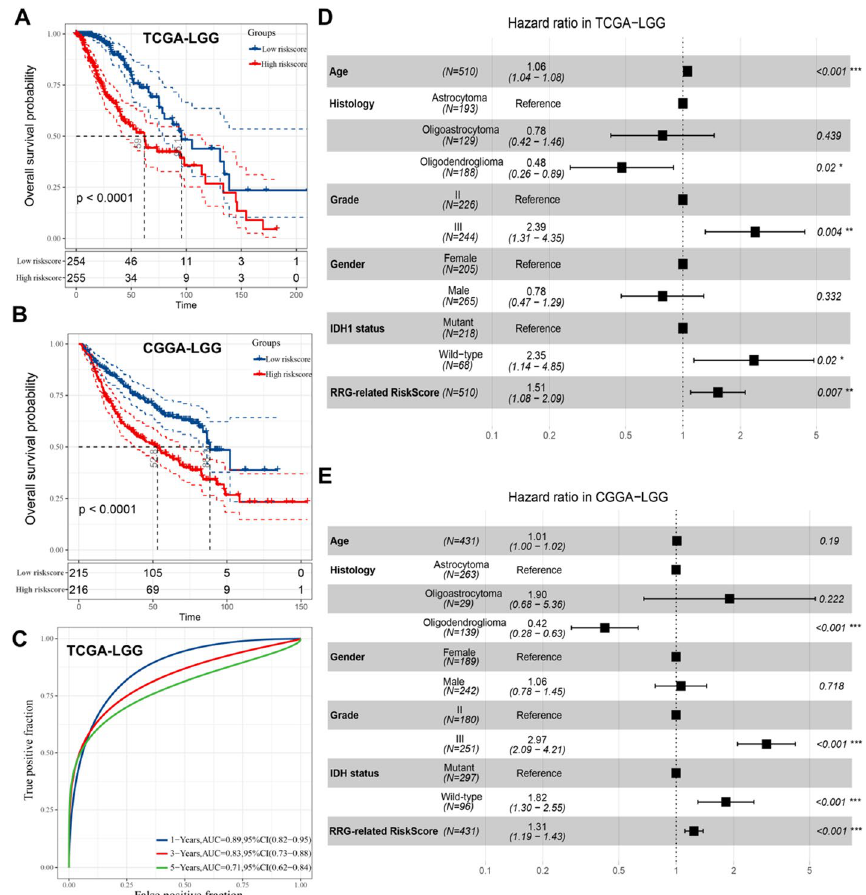
Fig. 7 Construction of RRG-related RiskScore. a , b Kaplan–Meier curves for OS showing the difference in survival between high-RiskScore group and low-RiskScore group in the TCGA ( a ) and CGGA ( b ) cohorts (log-rank test, p < 0.0001). High-RiskScore group is indicated in red line and low-RiskScore group in blue. c The predictive value of RiskScore in patients among the TCGA cohort (AUC:0.89, 083, and 0.71; 1, 3, and 5-years overall survival). d , e Multivariate Cox regression model analysis, which included the factors of RiskScore, age, gender, IDH1 status, grade, histology and patient outcomes in the TCGA ( d ) and CGGA ( e ) cohorts. The length of the horizontal line represents the 95% confidence interval (CI) for each group. The vertical dotted line represents the hazard ratio (HR) of all patients shown by the forest plot. * P < 0.05, ** P < 0.01, *** P <